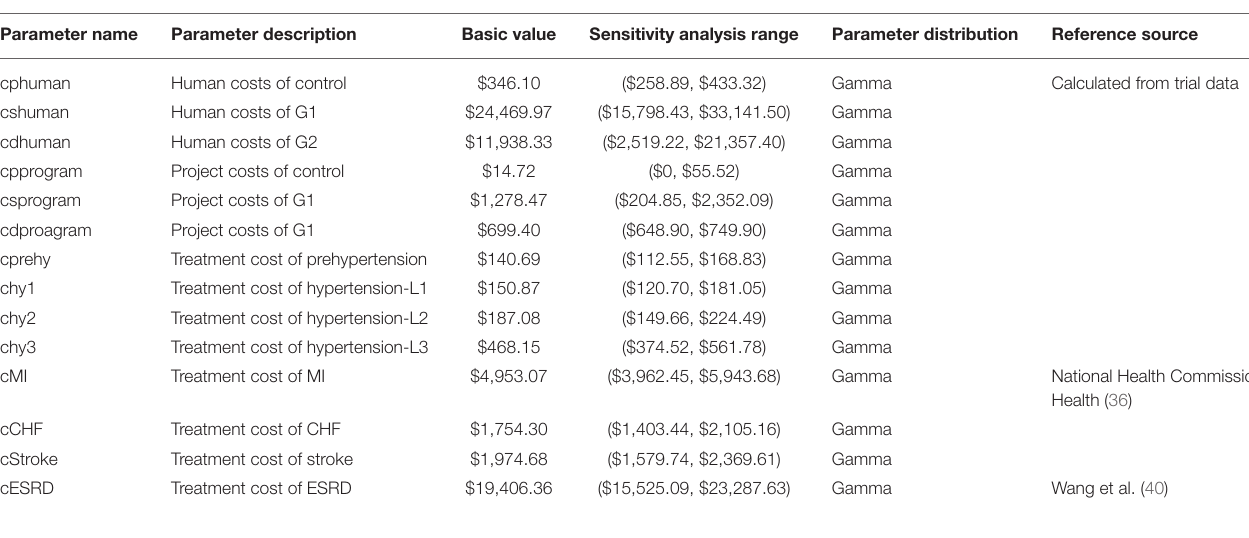
TABLE 6 | Annual costs of intervention measures and different health states (US